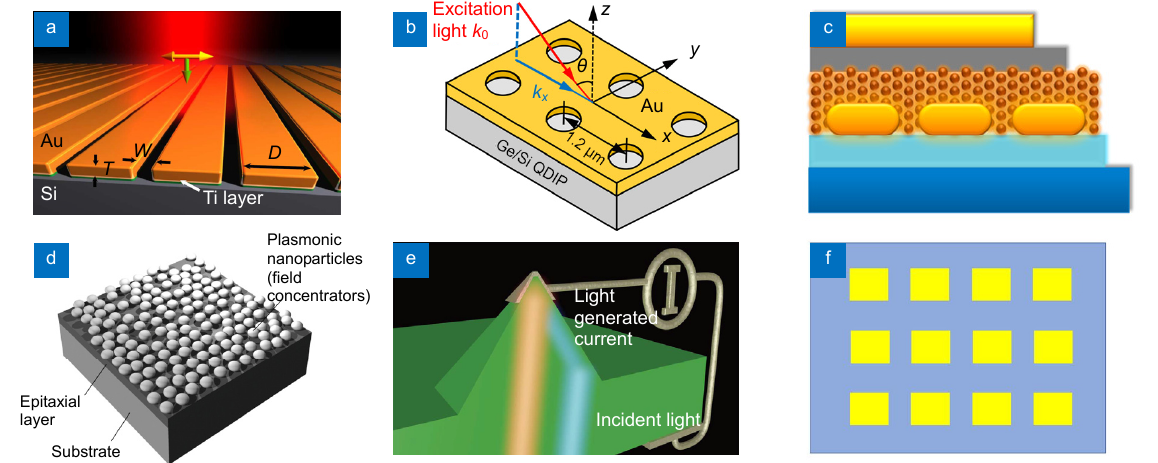
Fig. 3 | Different plasmonic structures . ( a ) Grating structure. ( b ) Two-dimensional hole array structure. ( c ) Nanorods inserted in absorber. ( d ) Nanoparticle. ( e ) Nanopyramids. ( f ) Micropatch. Figures reproduced from: (a) ref. 28 , Macmillan Publishers Limited; (b) ref. 31 , AIP Publishing ; (c) ref. 33 , American Chemical Society; (d) ref. 34 , Journal of Mechanical Engineering; (e) ref. 35 , Optical Society of